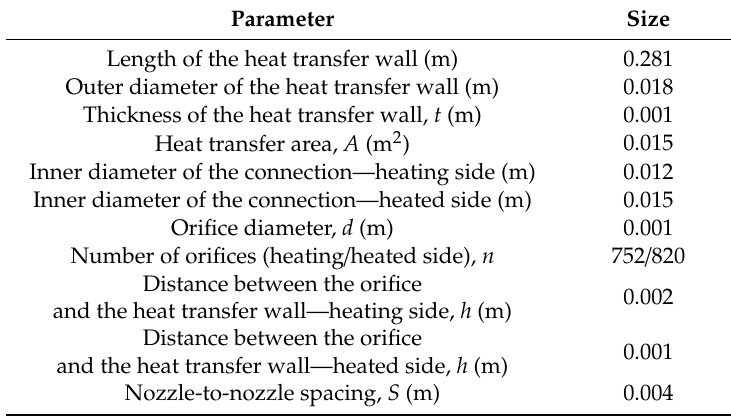
Figure 2. ( a ) Cross-section of the minijet heat exchanger and its model. ( b ) Cross-section of the classical shell-and-tube heat exchanger and its model. Table 1. Geometrical parameters of the MJHE.